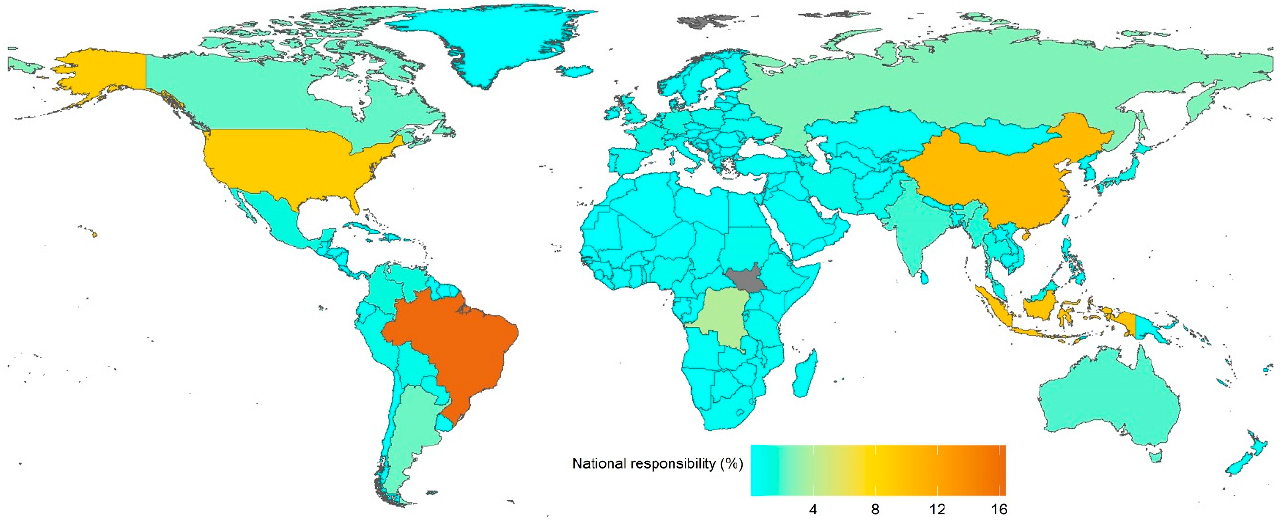
Figure 4. National level of responsibility over 28 years (1990–2018) for overshooting fair share of safe climate space with food systems.